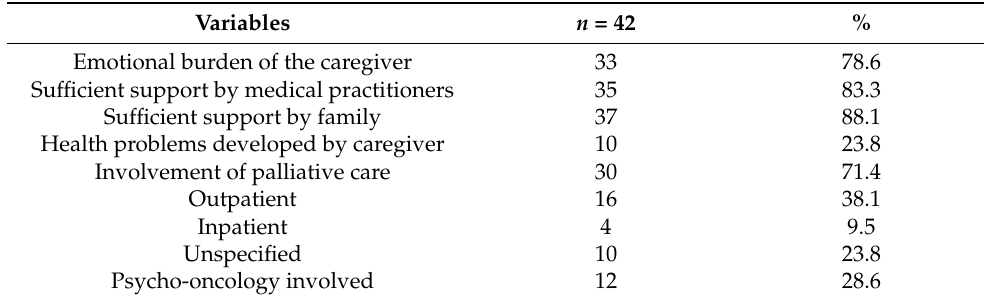
Table 3. The caregiver’s burden and support, with data in total number ( n ) and percentage (%) for categorical variables.